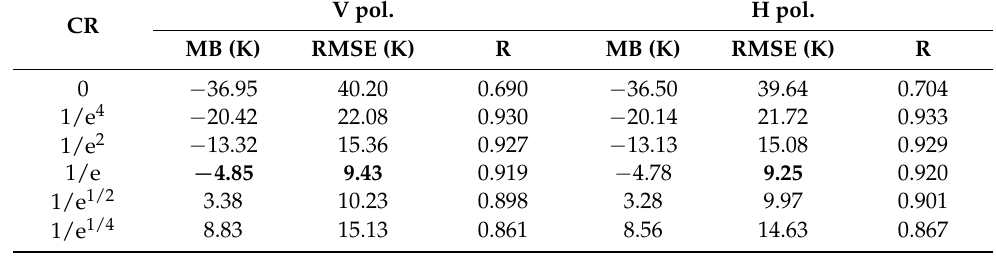
Table 5. Statistics for mean bias (MB), RMSE, and correlation coefficient (R) with different penetration depth thresholds (CR) at 89 GHz and a 55° incidence angle. The values in bold represent the highest accuracy among different CR thresholds. V pol. H pol. CR